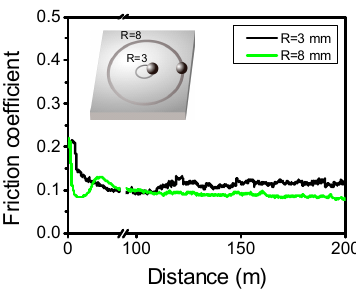
Figure 8. The friction coefficients of the H ‐ DLC/Al 2 O 3 sliding pairs under different rotational radii. The inset shows the experimental sketch under different rotational radii.